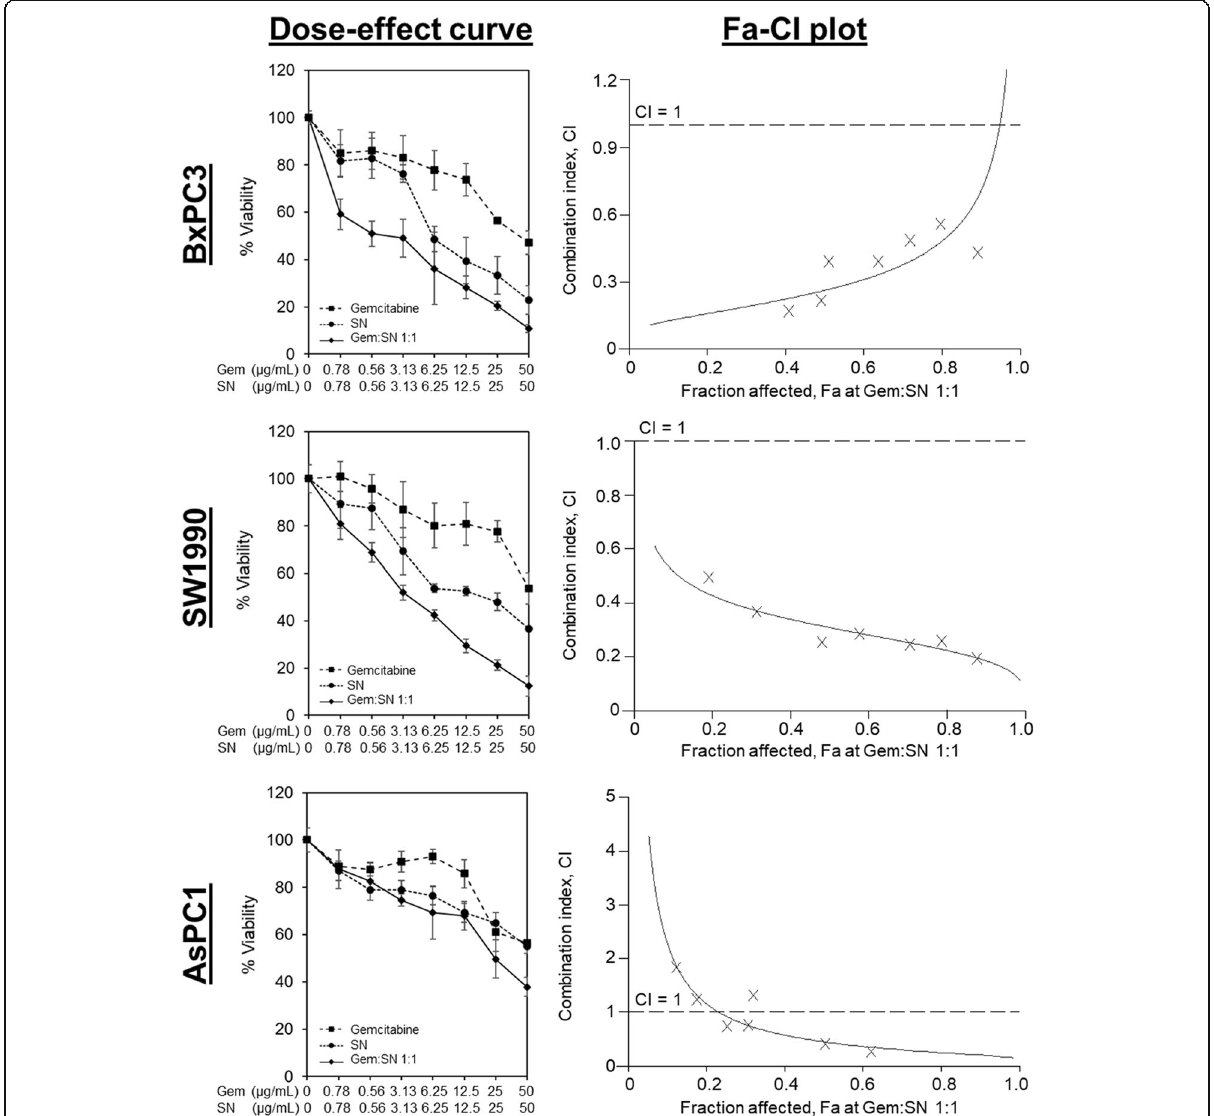
Fig. 1 Synergistic effects of SN extracts and gemcitabine on PDAC. The 72 h treatment effects of SN and gemcitabine combination and single agent alone on PDAC cell viability were illustrated in the dose-effect curves. The treatment concentration ratio of SN to gemcitabine shown was 1:1. Each bar represents the mean ± standard deviation of three independent experiments. The curves in the Fa-CI plot showed the CI versus the fraction of PDAC cells that were inhibited by the combined treatment of SN and gemcitabine at concentration ratio of 1:1. The combinations were synergistic when CI values were <